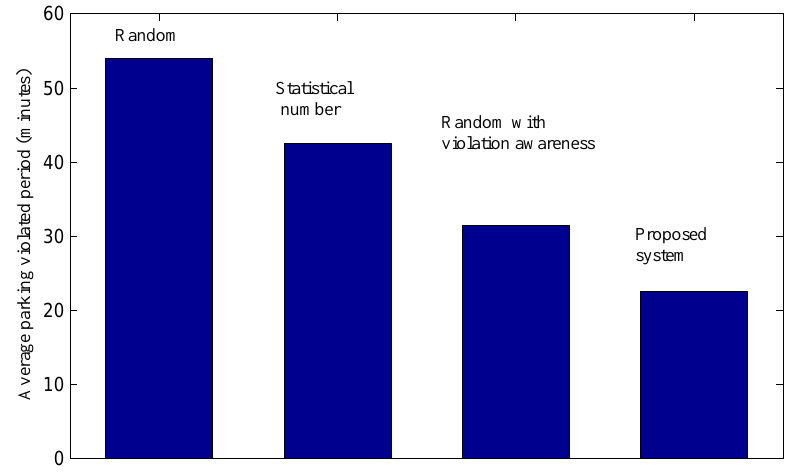
Figure 14. Average parking violation period of violating